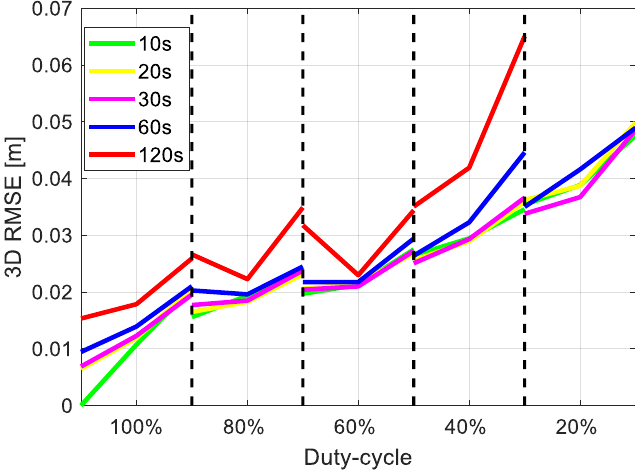
Figure 6. 3D RMSE of the reduced-dynamic orbits under different duty-cycles, observation sampling intervals, and mean satellite numbers using the IGS final products. The cases having 9, 7, and 6 satellites (on average) are given between each pair of the dashed lines.